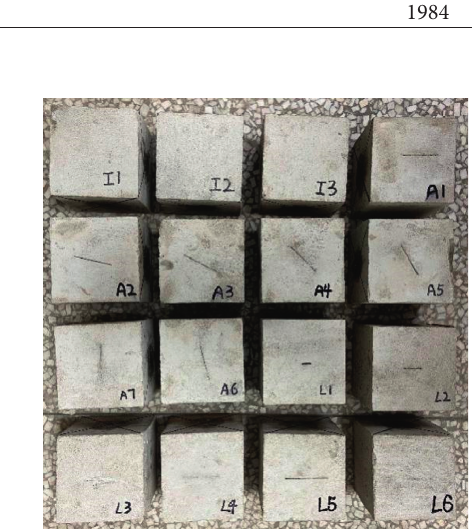
Figure 10: Mortar specimens for SHG test in experiment.